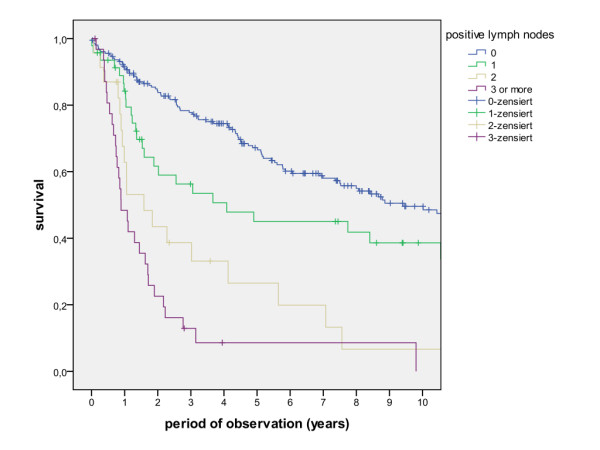
Survival of patients with different numbers of positive lymph nodes (log rank p < 0.001).